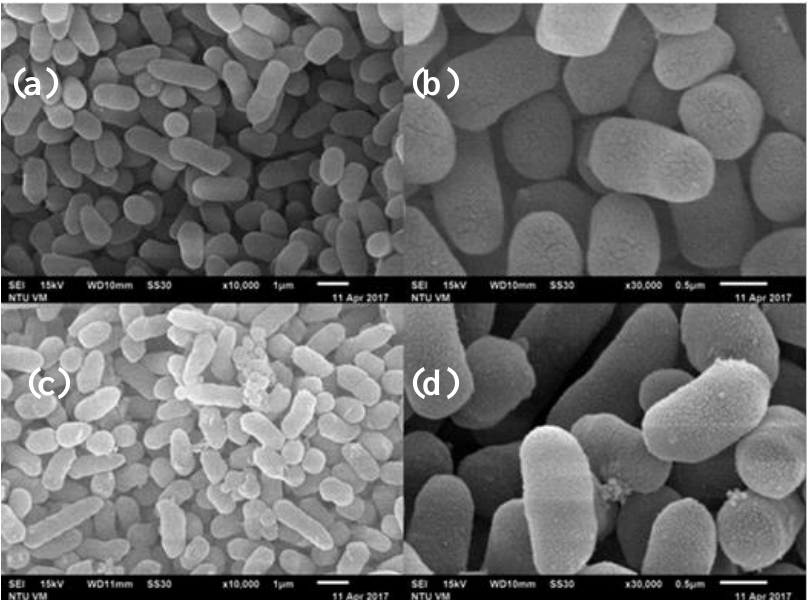
Figure 5. SEM micrographs of Enterobacter aerogenes cells in phosphate buffer. ( a ) and ( b ) Untreated cells; ( c ) and ( d ), cells treated with 500 MPa for 10 min.